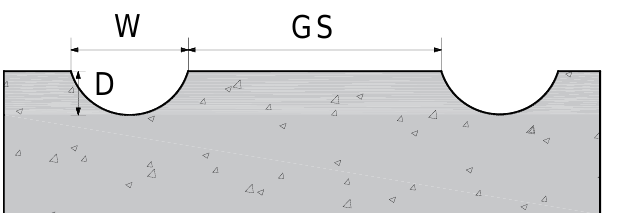
Figure 9. Curved groove parameters (W: the curved groove width, mm; D: the curved groove depth, mm; GS: the curved groove spacing, mm). Table 4. Factors and levels of the orthogonal test.